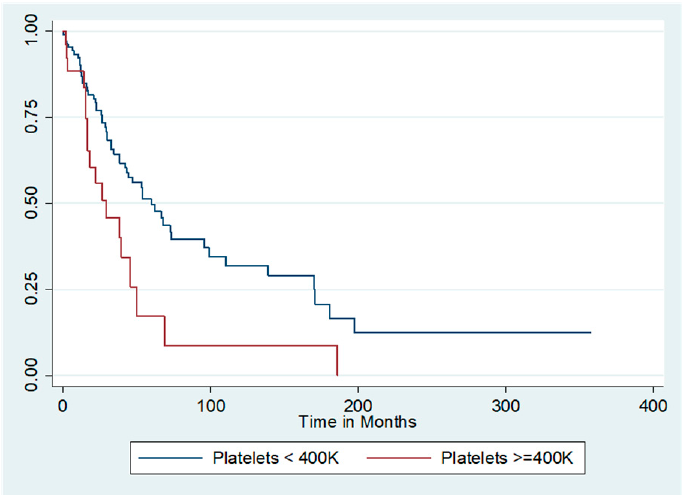
Figure 1. Unadjusted overall survival by thrombocytosis. Median overall survival (OS) was significantly affected by presence of thrombocytosis. Median OS of those with thrombocytosis was 29.4 months compared to 60 months in those without thrombocytosis (log-rank p = 0.007).